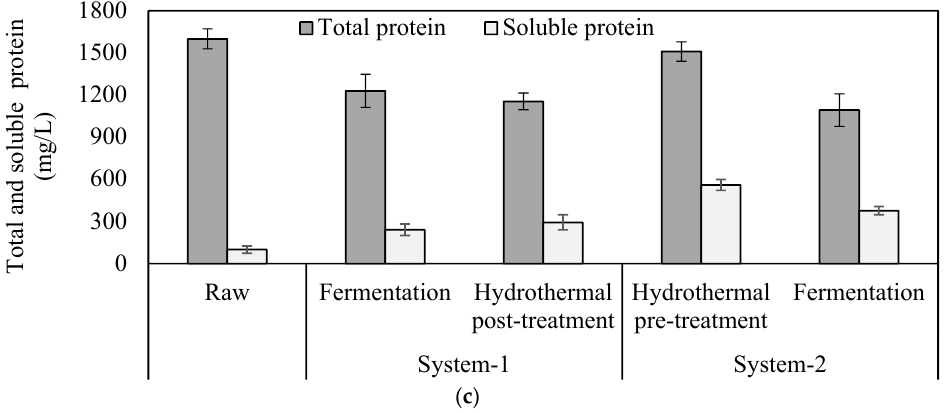
Figure 2. Concentrations of ( a ) TCOD and SCOD, ( b ) total and soluble carbohydrates, and ( c ) total and soluble protein in raw, treated, and fermented SSO. (TCOD: Total Chemical Oxygen Demand, SCOD: Soluble Chemical Oxygen Demand, SSO: Source Separated Organics)